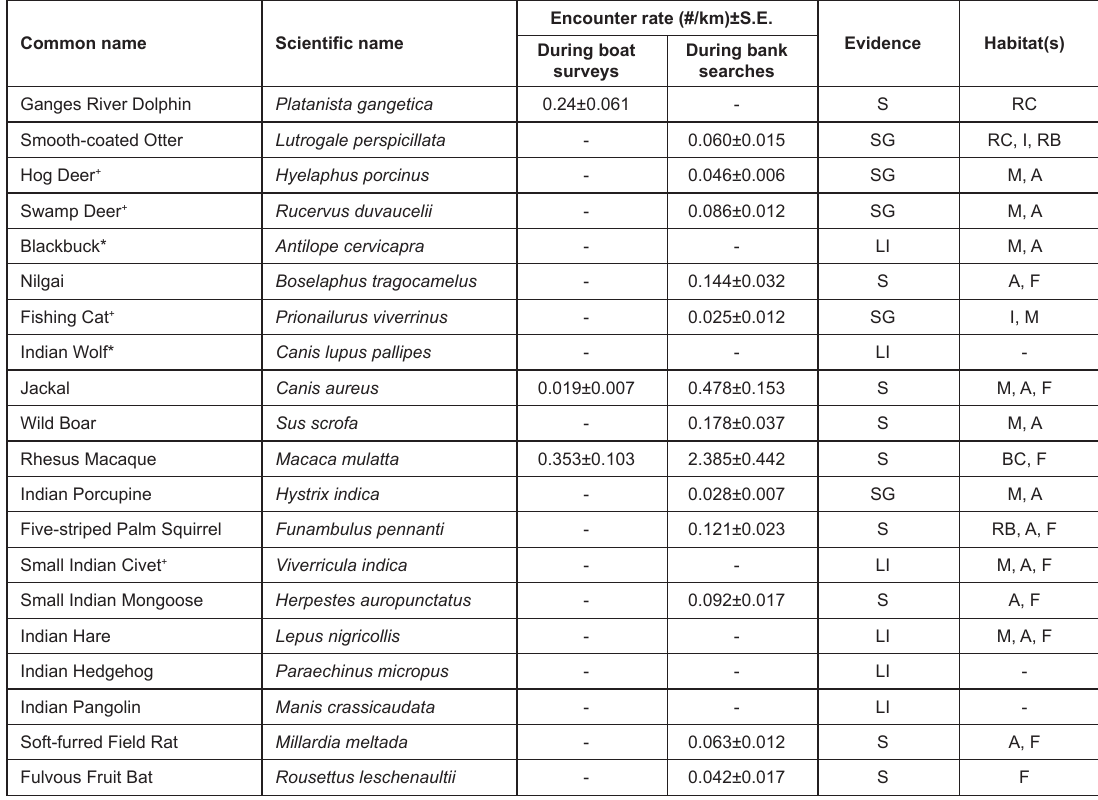
Table 1. List of mammalian species recorded along upper Ganges and its banks.